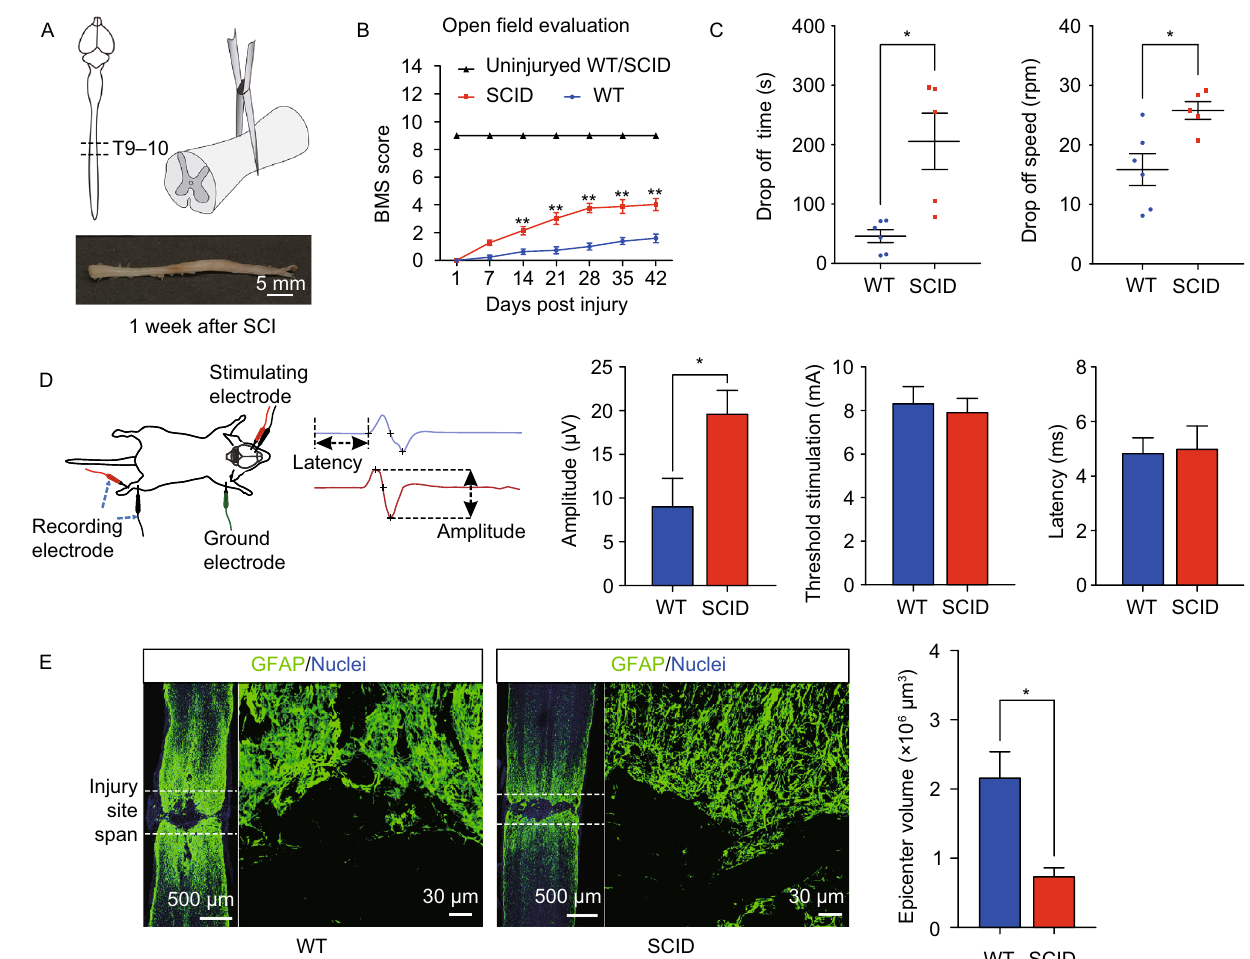
Figure 1. SCID mice showed better motor functional recovery than WT mice after SCI. (A) Schematic illustration of anatomical positioning of SCI (upper left diagram) and SCI crush model using an artery clamp with 60 g constant force (upper right diagram). The lower panel shows an example of the gross anatomy of spinal cord tissue 1 week post-injury. (B) BMS open- fi eld test to show hindlimb motor functional recovery of SCID and WT mice from 0 d to 42 d after SCI (mean±SEM; ** P <0.01, n ≥ 15, unpaired Student ’ s t -test with comparison between two groups at each time point). (C) Rotarod performance of WT and SCID mice at 42 d post-injury. The left panel shows the drop-off time at 15 rpm constant speed, and the right panel shows the drop-off speed during 0 to 40 rpm acceleration (mean±SEM; n =6, * P <0.05, unpaired Student ’ s t -test). (D) Electrophysiological analysis of SCID and WT mice at 42 d post-injury. The left two panels show a schematic graph of MEP recording and representative MEP traces. The right three panels show signi fi cant differences in Amplitude (Amp), but not in threshold stimulation (TS) or latency between SCID and WT groups. (mean±SEM; n ≥ 5, * P <0.05, unpaired Student ’ s t -test). (E) GFAP immunohistochemical analysis demonstrated signi fi cantly greater lesion volumns in WT mice than SCID mice. Dotted lines demarcate the epicenter span with high magni fi cation images to the right of each panel (mean±SEM; n =6, * P <0.05, unpaired Student ’ s t